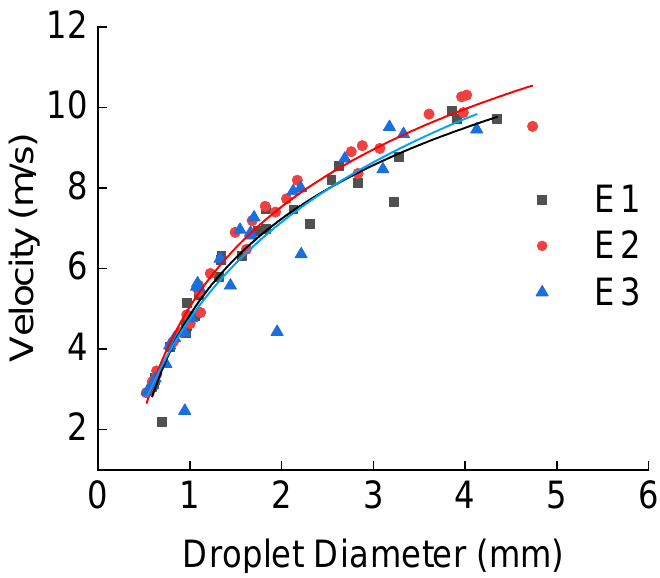
Figure 15. Relationship between average droplet diameter and velocity sprayed from elliptical nozzles with different aspect ratios. (E1, E2, and E3 refer to the elliptic nozzles with aspect ratios of 1.43, 2, and 2.58, respectively).